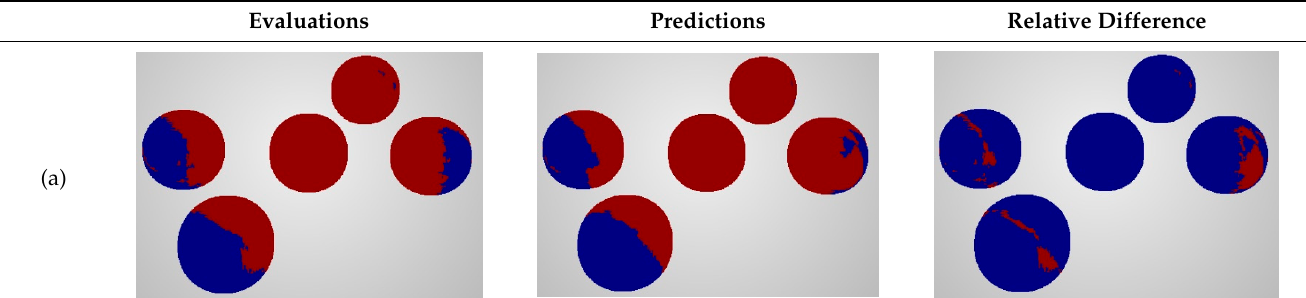
Table A1. Comparison of predictions and evaluations of an average 360-degree scene from Figure 16: (a) reconstruction’s coverage (red points represent covered areas for evaluations and predictions, and for relative difference, invalid predictions), (b) density, and (c) accuracy.